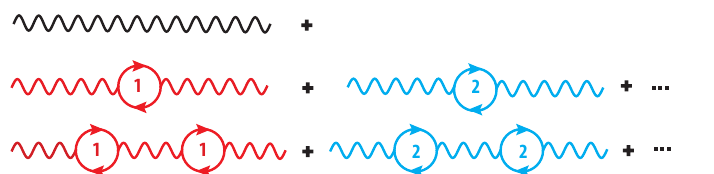
Figure 1. Vacuum polarization in the one-loop approximation. All types of virtual pairs in nature (labeled as 1,2, . . .) polarize the vacuum. This polarization is maximal for a free electromagnetic field for which ω = | k | c